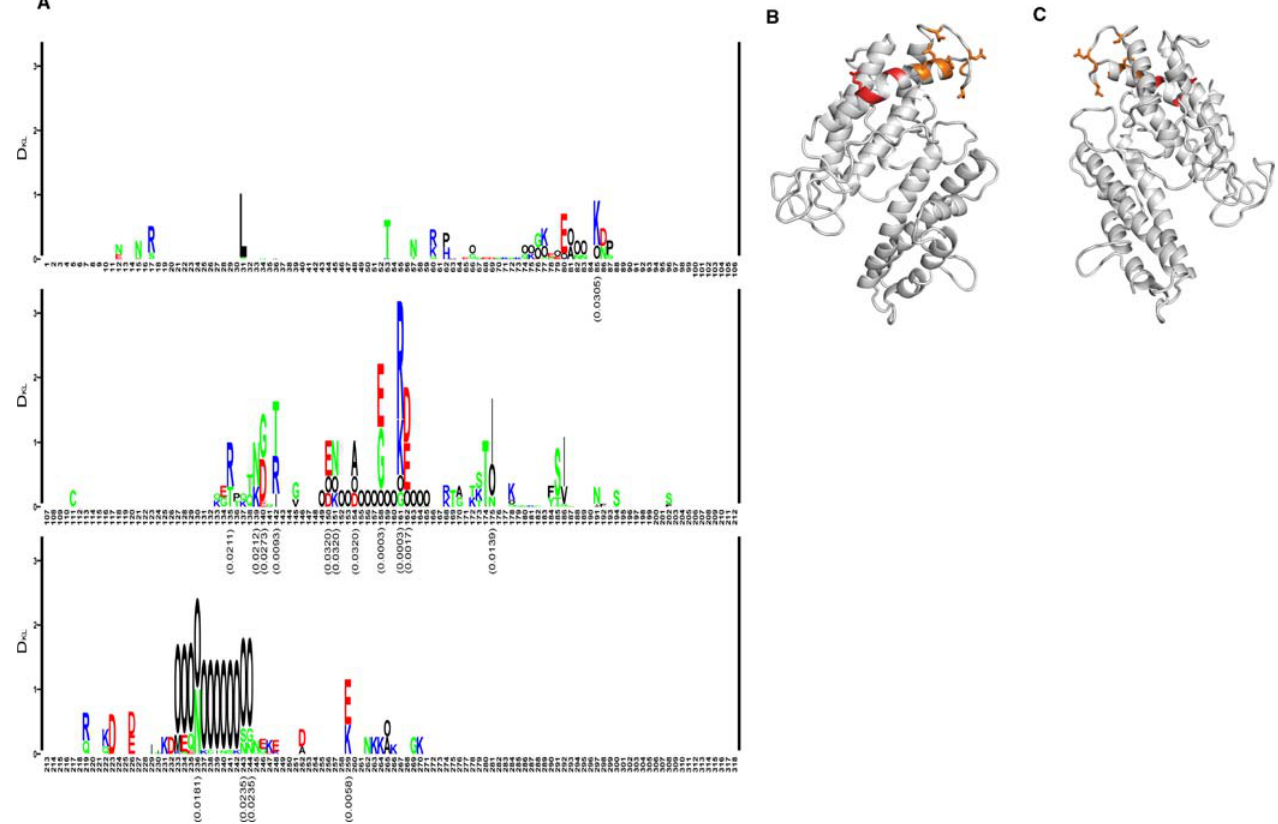
Figure 4. Sequence Differences in Infections with Different Parity (A) Kullback-Leibler sequence logo based on a multiple alignment of the DBL3X region (Figure 3). The sequences in the alignment were split into two groups of equal size: 21 sequences obtained from primigravidae and 21 sequences from multigravidae women. The x-axis shows amino acid positions in the alignment. The height of a position indicates the amount of difference between the two groups according to the symmetric Kullback-Leibler distance, and the letters indicate the amino acids contributing to this difference. The letter ‘‘ O ’’ has been chosen to signify gaps in the alignment. Polar amino acids are green, basic are blue, acidic are red, and hydrophobic amino acids are black. P -values indicating the significance of D KL based on the parity grouping compared to random groupings are shown below positions where p , 0.05. (B) DBL3X model showing the position of amino acids that were differentially found in primi-gravidae and multigravidae women. Residues in the region 135–175 of moderately significant difference are shown in orange, and highly significant residues (positions 158, 161, and 162) are shown in red. (C) The model (B) rotated 180 degrees so it is positioned similar to Figure 1C.